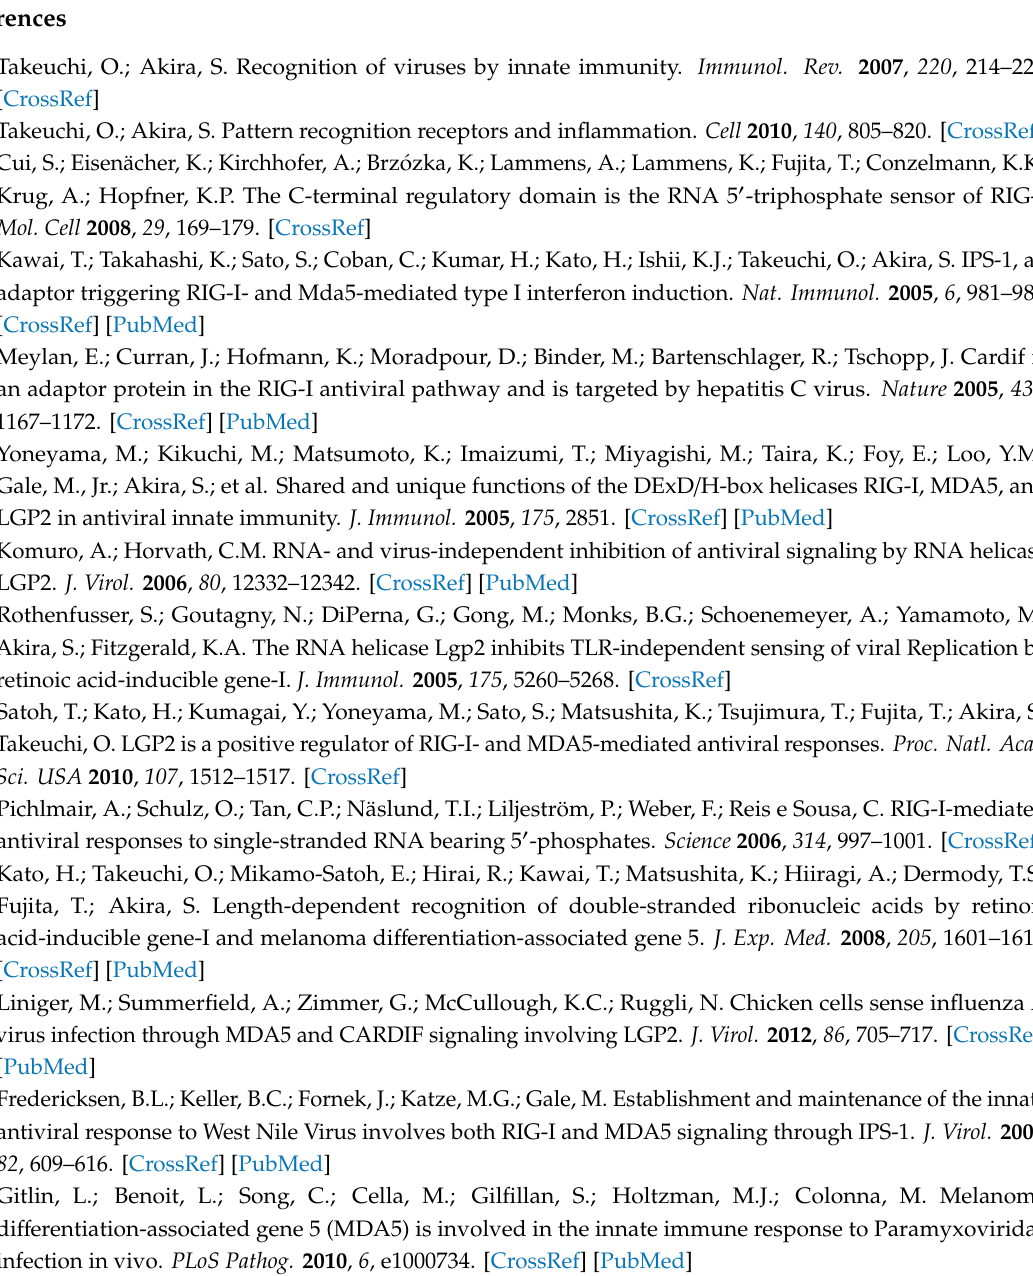
used for cloning, Table S2: The primers used for qRT-PCR, Table S3: Di ff erentially expressed genes in chMDA5 compared with control, Table S4: Di ff erentially expressed genes in poly(I:C) compared with control, Table S5: Genes similarly regulated in both chMDA5-N and Poly(I:C) groups compared with control, Table S6: The enriched GO biological process in chMDA5 compared with control, Table S7: The enriched GO biological process in poly(I:C) compared with